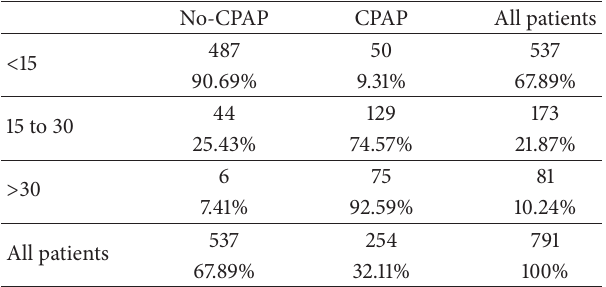
Table 3: Intention to treat with CPAP according to mAHI. Relation- ship with